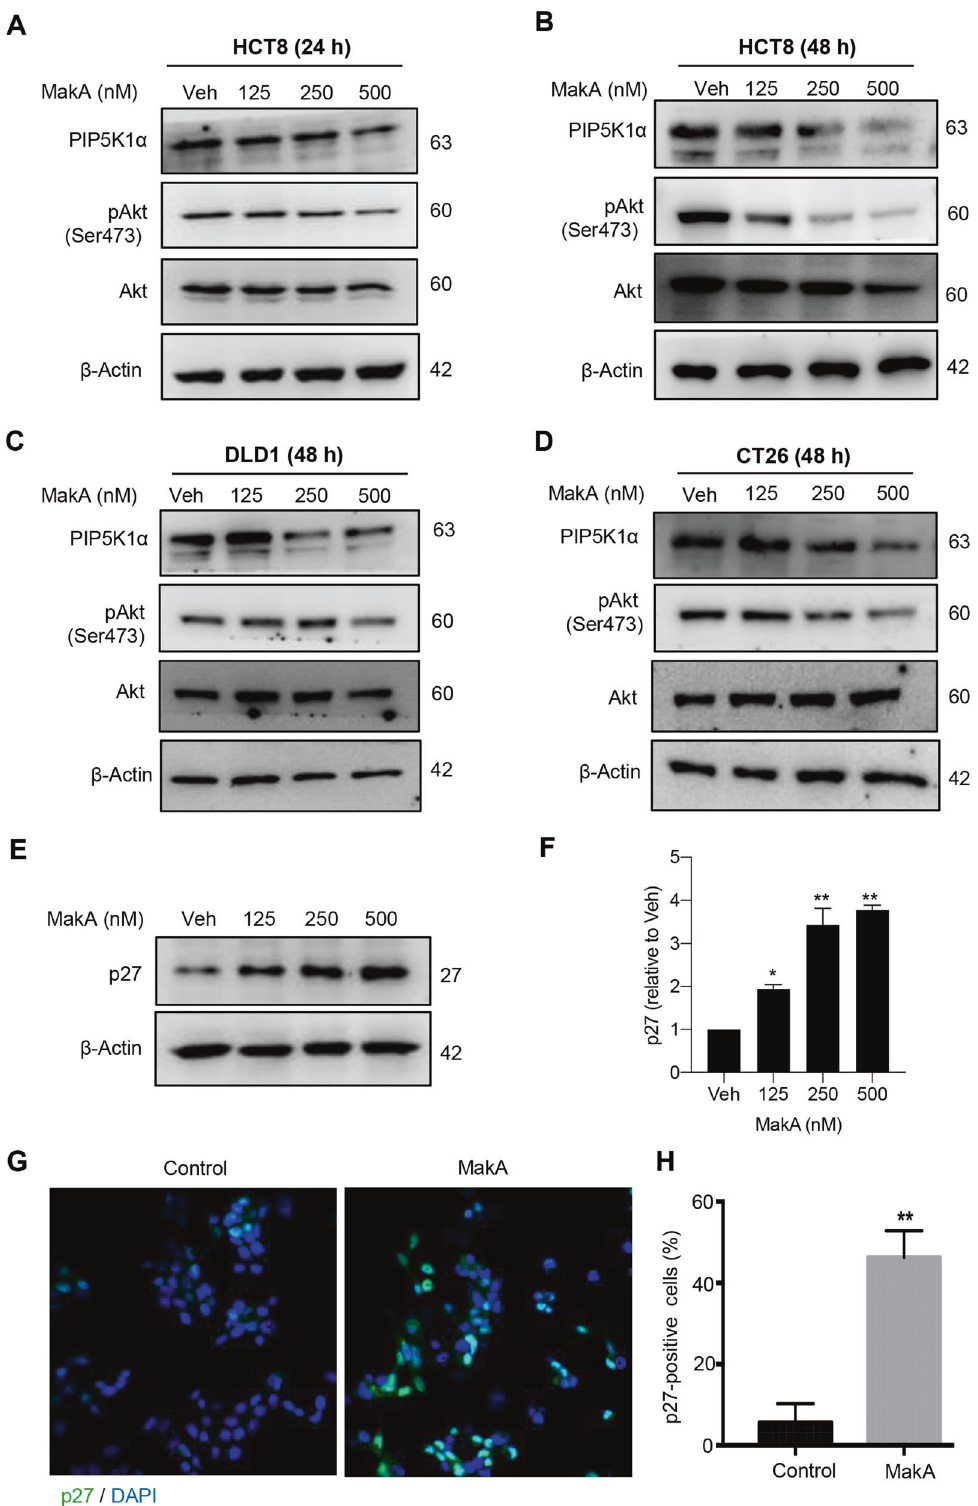
Fig. 3 MakA inhibits PIP5K1 α , and Akt activity, and induces p27 expression. A – D PIP5K1 α , pAkt, and total Akt levels are shown in immunoblot images of HCT8, DLD1, and CT26 cancer cells treated with increasing concentrations of MakA, as indicated. The results are representative of at least two independent experiments. E Western blot analysis of HCT8 cells treated with increasing concentrations of MakA reveals the levels of p27 protein expression. F Histograms illustrate the quanti fi cation of p27 relative to total actin from the experiment in ( E ). Data are representative of three independent experiments and are expressed relative to cells treated with vehicle (20mM Tris-HCl); bar graphs show mean ± s.d. The signi fi cance of replicates was determined using a one-way analysis of variance * p ≤ 0.05 and ** p ≤ 0.01. G Representative confocal microscopy images of p27 expression (green) after treatment of HCT8 cells with or without MakA. Nuclei were counterstained with DAPI (blue). H A bar graph displaying the percentage of p27-positive cells in HCT8 cells treated with vehicle or MakA. Quanti fi cation is obtained from the experiment in ( G